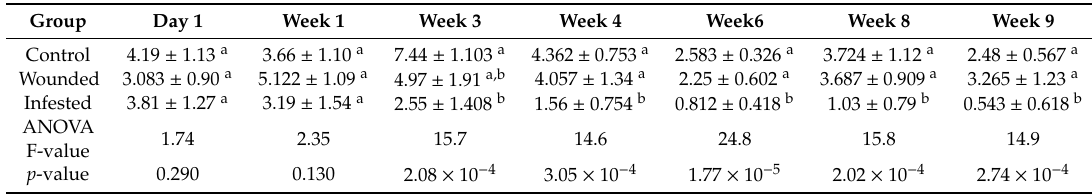
Table 2. Mean ± SD and results of one-way ANOVA of the maximum photosynthesis rate (A max ) at each time post-infestation. Di ff erent letters indicate significant di ff erences based on ANOVA following Tukey multiple comparison test ( p >